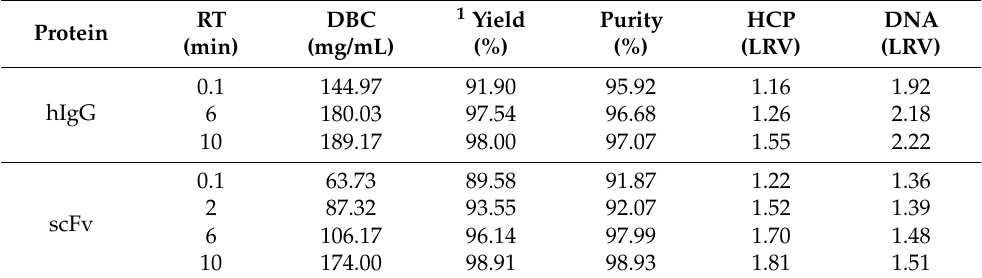
Figure 7. Bind and elute cycles of hIgG ( a ) and ( b ) and scFv ( c ) and ( d ) for PBT-GMA-SO 3 membranes at different residence times. Chromatograms ( left ) and DBC100%, Yield and Purity ( right ) as a function of residence times. Table 4. Performance of PBT-GMA-SO 3 membranes for the purification of antibodies (hIgG and scFv) from CHO cell